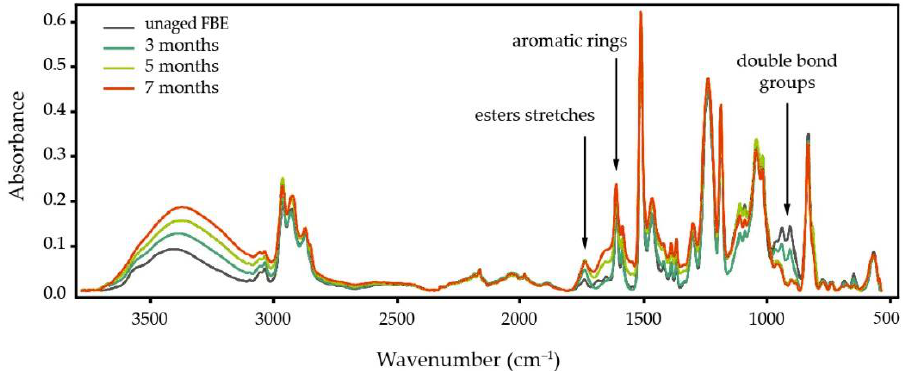
Figure 7. Degradation of FBE molecular structure caused by water sorption: after three months hydrothermal ageing, water can disrupt epoxy double bonds and cause chain scission for the backbone. Copyright 2019. Reproduced from [92] with permission from Elsevier Ltd.